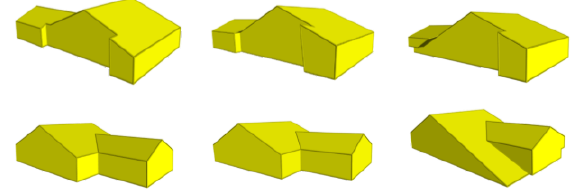
Figure 6: Reconstructed detached house in from the original point cloud (left) and the subsamples (0.95m middle, 1m right). Similarly, for the tall building (Figure 7), subsampled version of the origianl point cloud are synthetically generated randomly. Where the original point cloud has 100% density, the thinned version are at 80%, 75% and 20%.